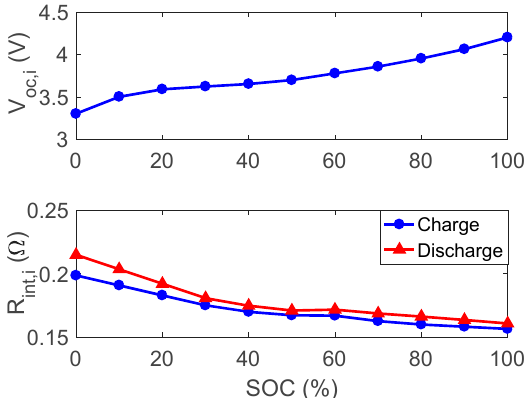
Figure 9. Parameters of a single battery cell for Rint battery model. Figure. 9. Parameters of a single battery cell for Rint battery model. Figure. 9. Parameters of a single battery cell for Rint battery model.